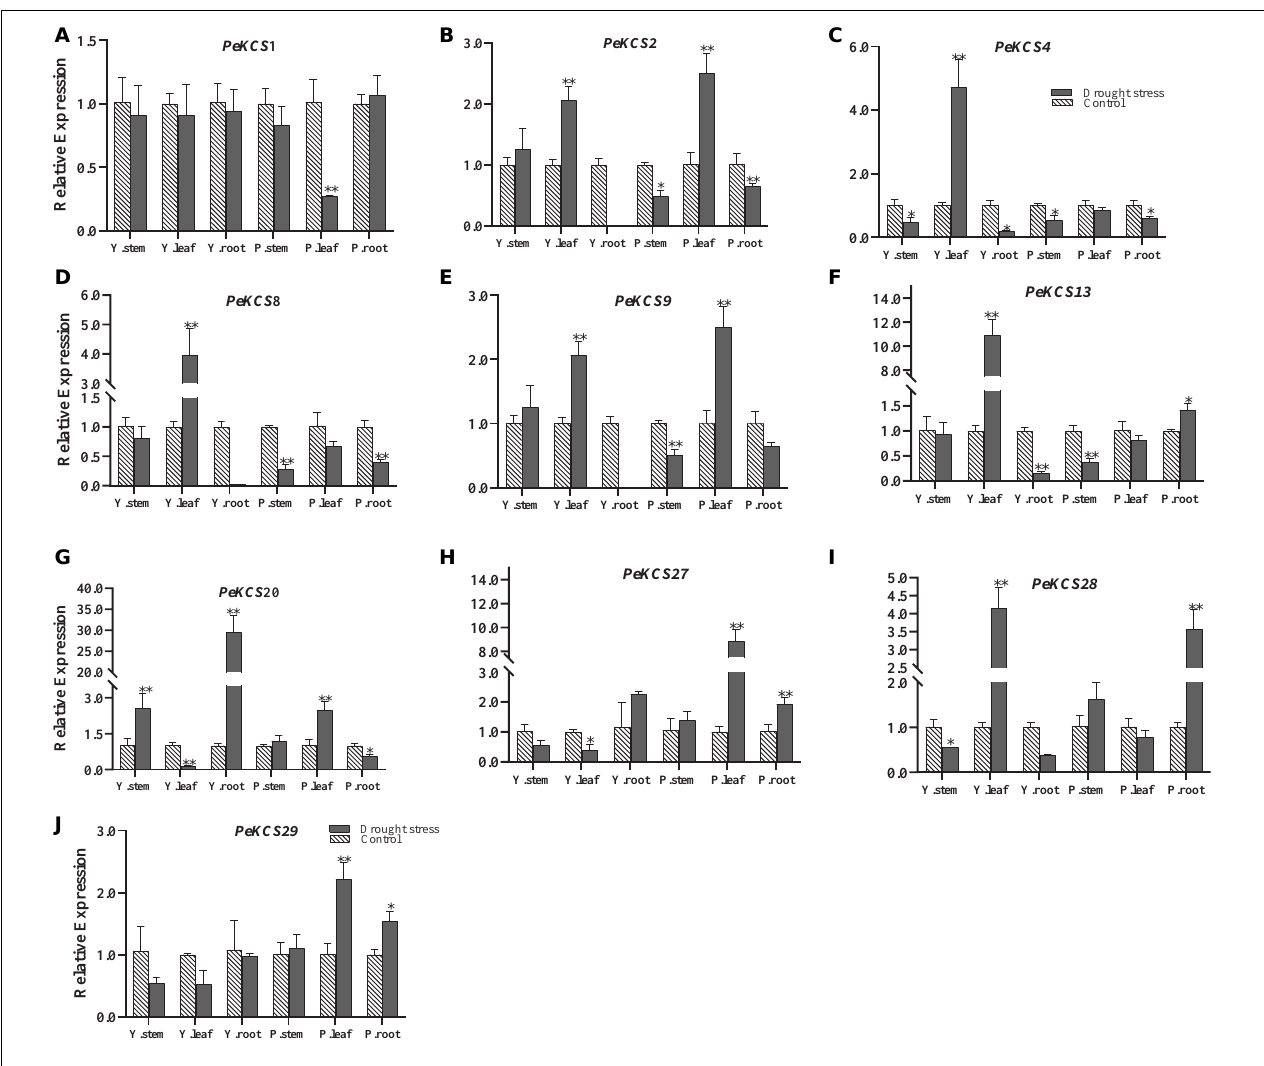
FIGURE 12 | The relative expressions of PeKCS genes in stem, root and leave tissues of yellow and purple passion fruit plants under control and drought stress conditions. The relative gene expression levels were calculated using the 2 - (cid:49) (cid:49) ct . Plants with regular watering were taken as control. Vertical bars represent means ± SD ( n = 3). The * and ** shows significance at p ≤ 0.05 and p ≤ 0.01, respectively, among control and drought stress condition according to Students t -test. Y, yellow passion fruit; P, purple passion